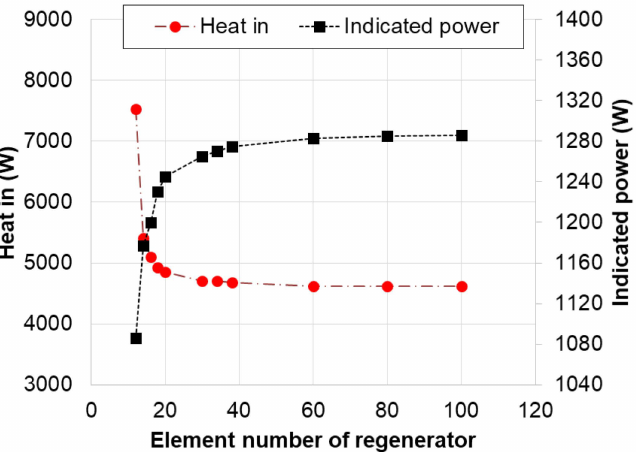
Figure 7. Predicted heat in and indicated power for the RE-1000 engine using the finite difference method (FDM) for the